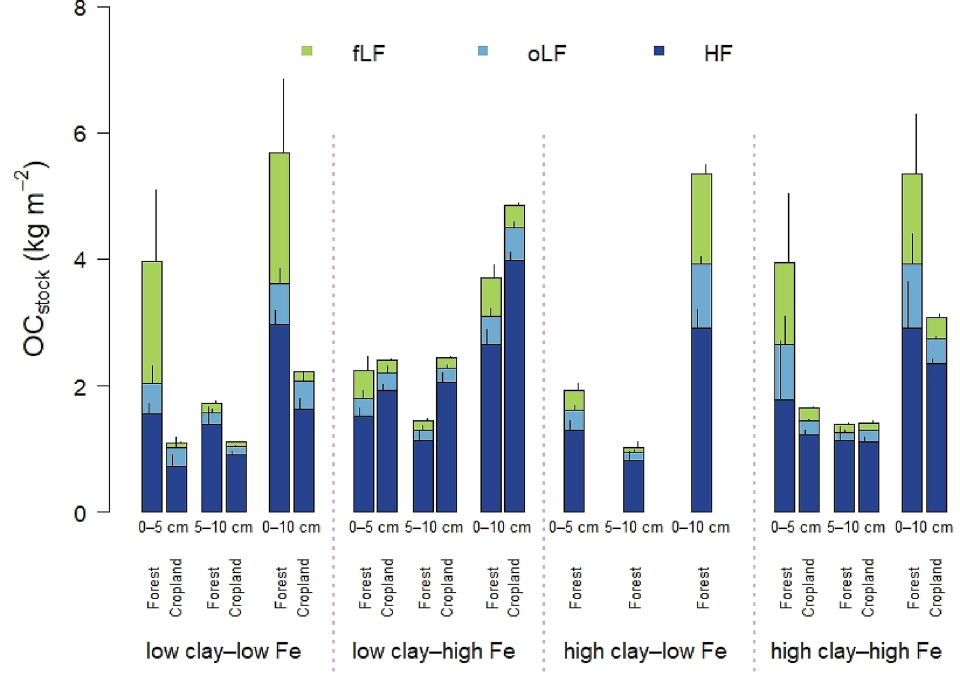
Figure 3. Bulk OC stocks related to soil density fractions (fLF and oLF = free and occluded light fraction; HF = heavy fraction) in mineralogical combinations under forest and cropland separated by soil depth. Sample numbers for the combinations are as follows: ‛ low clay ‒ low Fe’ under forest ( n = 4), ‛ low clay ‒ high Fe’ under forest ( n = 4), ‛ high clay ‒ low Fe’ under forest ( n = 3), ‛ high clay ‒ high Fe’ under forest ( n = 7); all cropland combinations ( n =